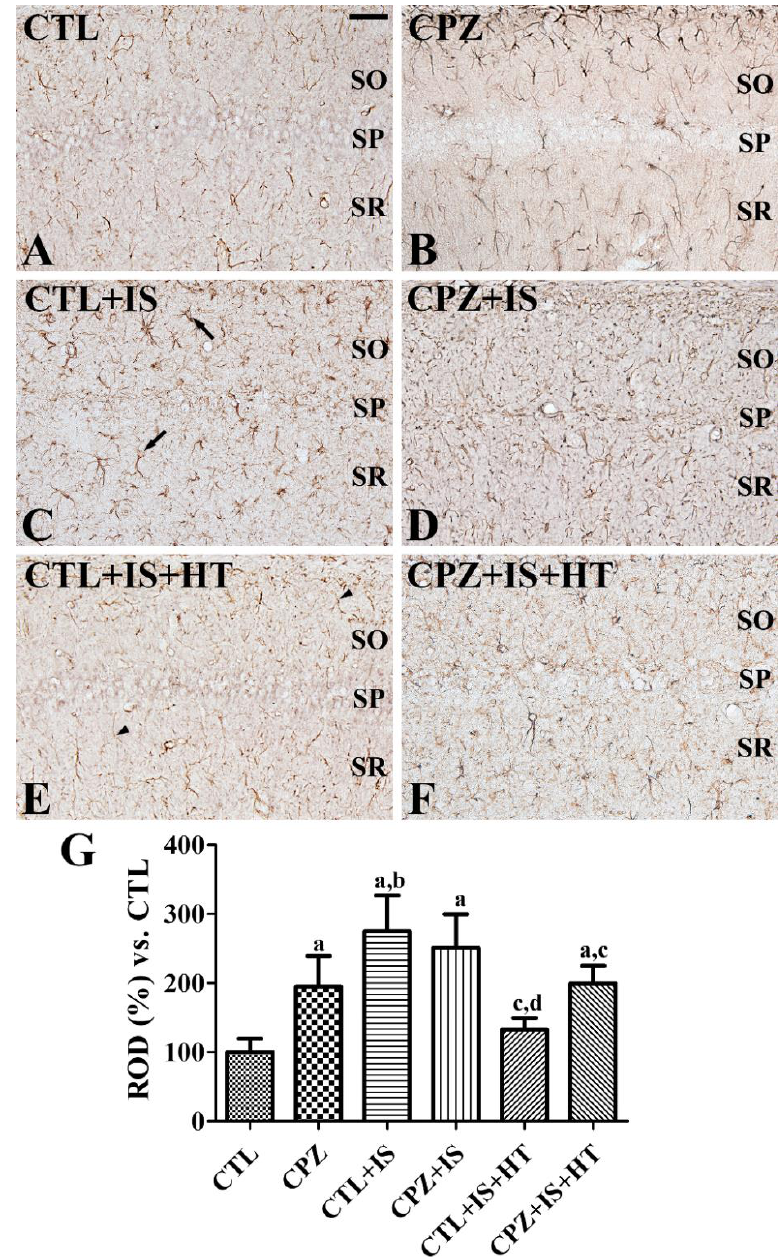
Figure 3. Glial fibrillary acidic protein (GFAP) immunohistochemistry in the gerbil hippocampal CA1 region of the CTL ( A ), CPZ ( B ), CTL + IS ( C ), CPZ + IS ( D ), CTL + IS + HT ( E ), and CPZ + IS + HT ( F ) groups. GFAP-immunoreactive astrocytes were observed in the hippocampal CA1 region. Note that many GFAP-immunoreactive astrocytes have long processes in the CPZ group and punctuated cytoplasm with thickened processes (arrows) in the CTL + IS, CPZ + IS, and CPZ + IS + HT groups, while many astrocytes in the CTL + IS + HT group have thin cytoplasm and processes (arrowheads). SP, stratum pyramidale; SO, stratum oriens; SR, stratum radiatum. Scale bar = 50 μM. ( G ) Relative optical densities (RODs) were expressed as a percentage of the GFAP immunoreactivity detected compared to that of the CTL group in the hippocampal CA1 region for each section ( n = 5 per group, a p < 0.05, significantly different from the CTL group; b p < 0.05, significantly different from the CPZ group; c p < 0.05, significantly different to the CTL + IS group; d p < 0.05, significantly different from the CPZ + IS group). Error bars indicate standard deviation.